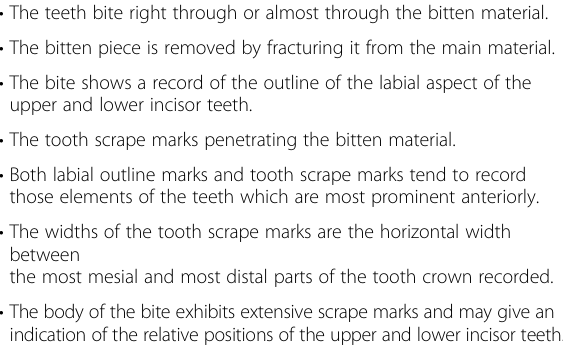
Table 2 Characteristics of Type 3 bites (adapted from Webster